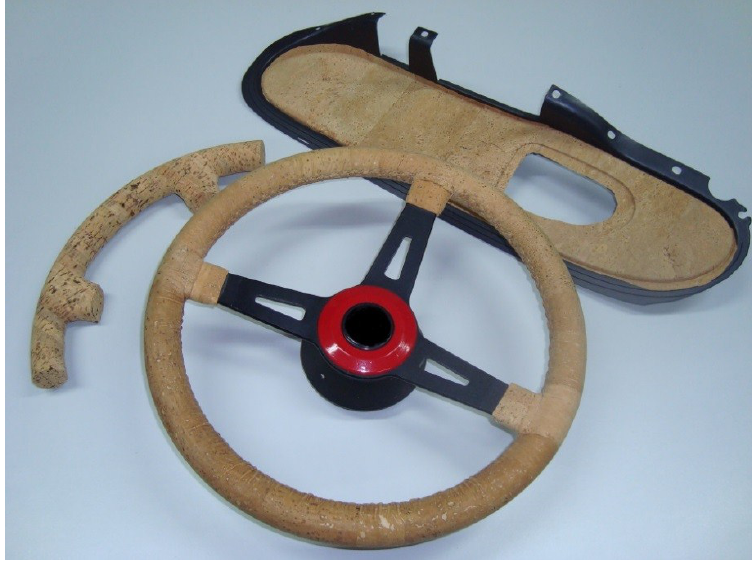
Figure 3. Steering wheel and door panel covered with